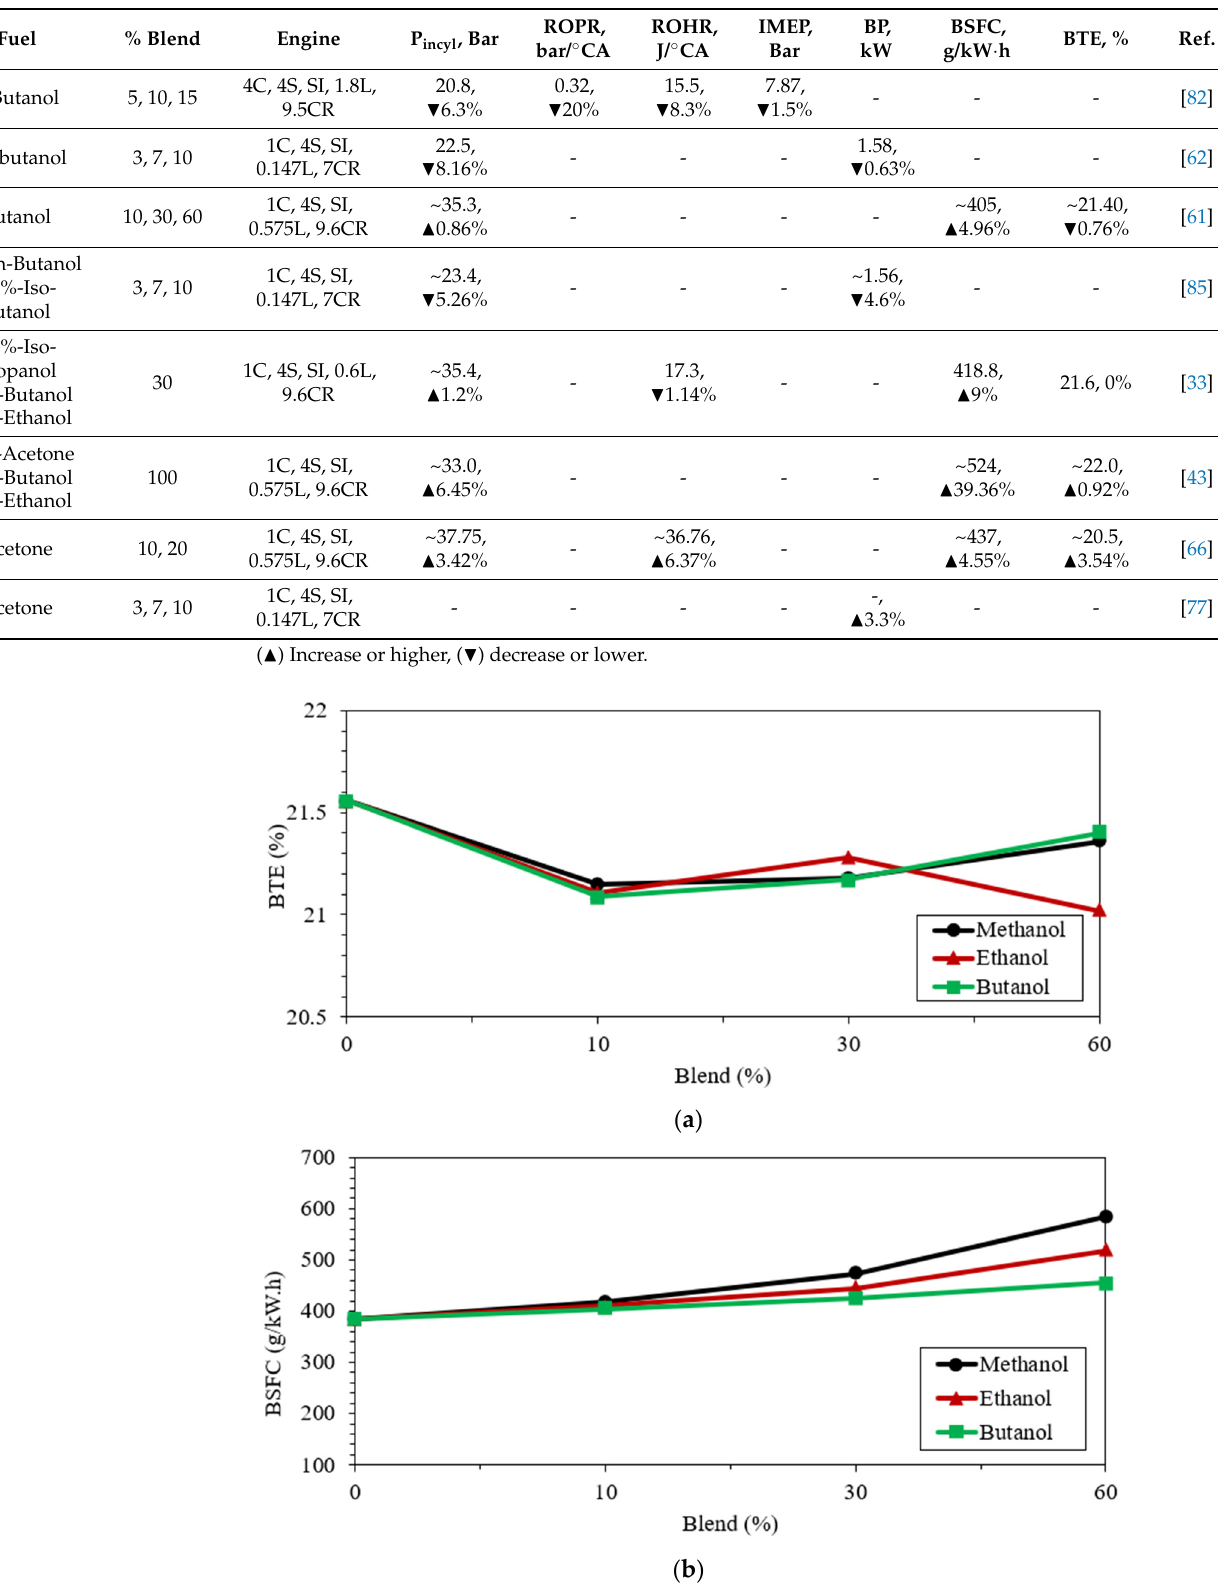
Figure 7. ( a ) BTE and ( b ) BSFC comparison between methanol, ethanol, and butanol blended with conventional gasoline [61] .